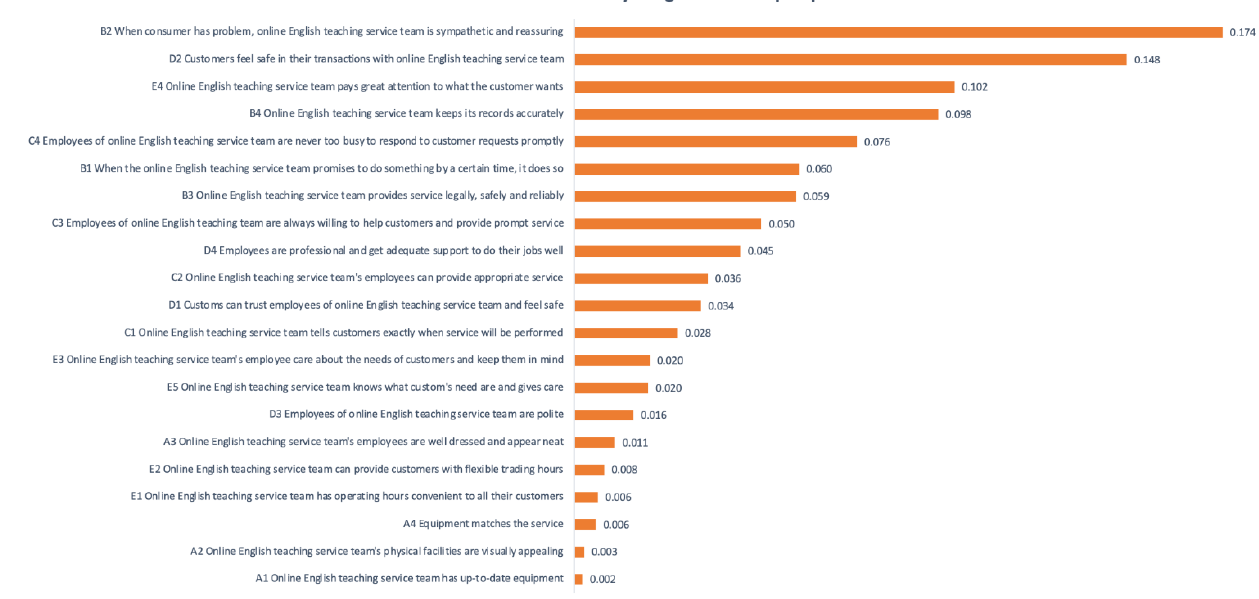
Figure 5. Indicators that were ordered by weight from the perspective of consumers.